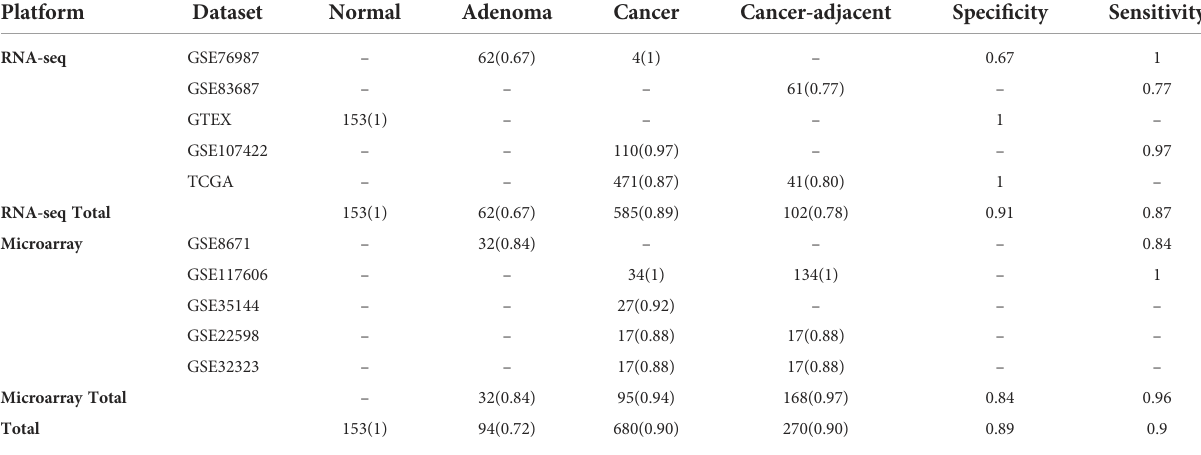
TABLE 3 The performance of the lncRNA pair biomarkers in the validation dataset. . Platform